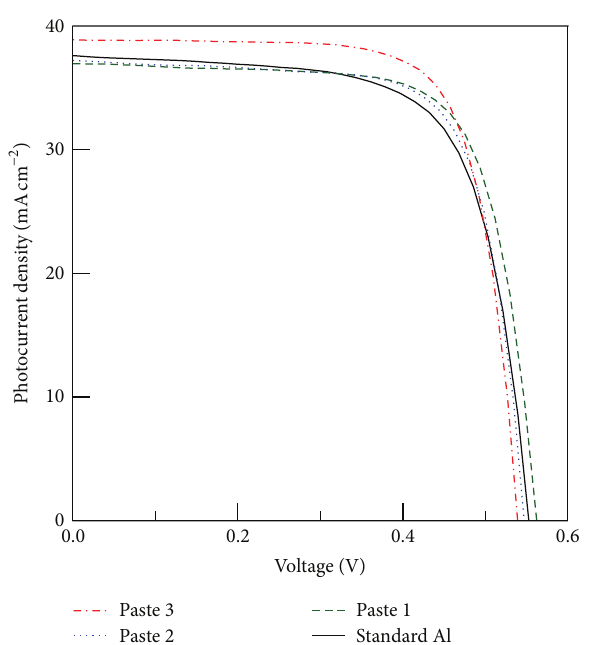
Figure 4: 𝐼 - 𝑉 curve of the best cells with polyvinyl alcohol-based aluminum pastes (Paste 1, Paste 2, and Paste 3) compared to the best cell with commercially available aluminum